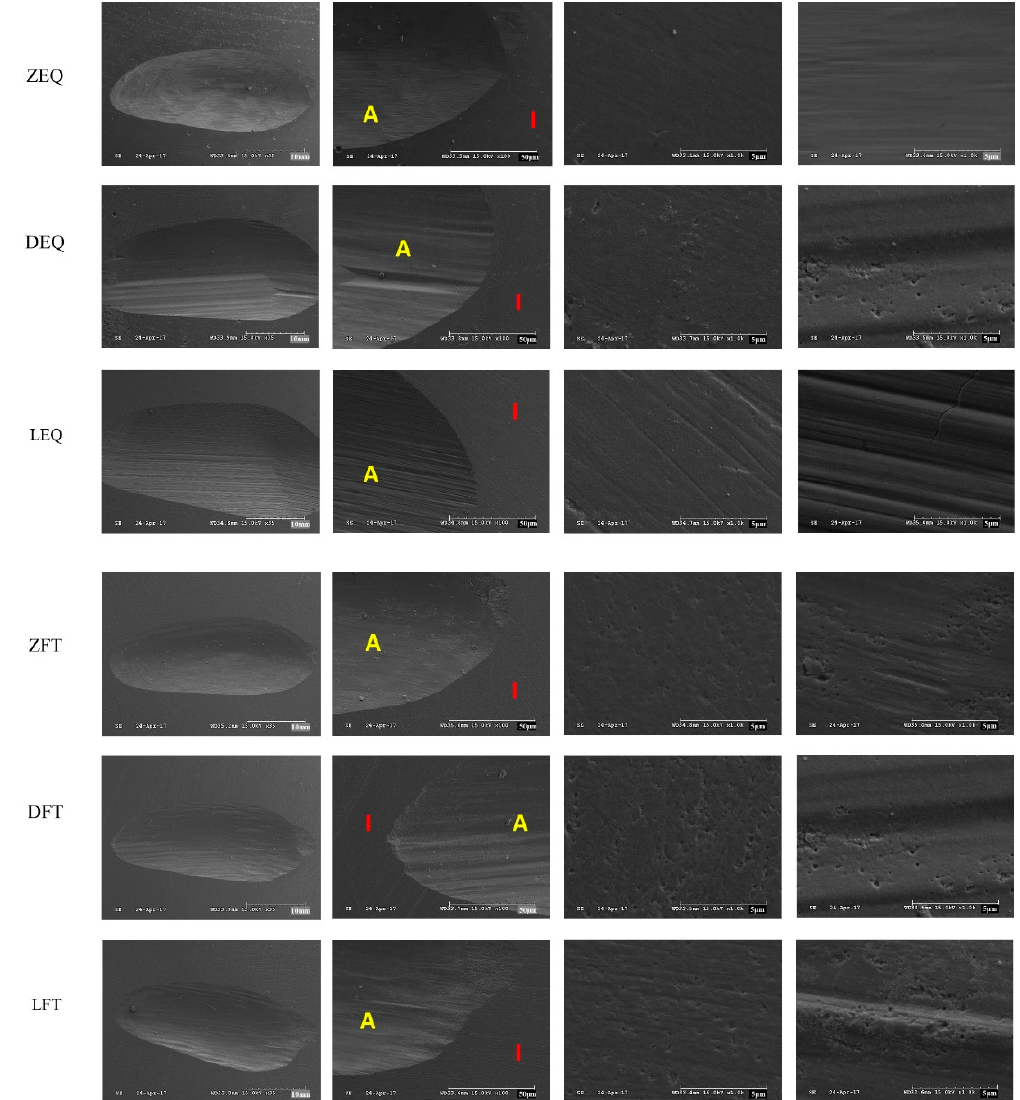
Figure 8. Representative SEM images of composite resin surfaces: ZMG, zirconia opposing MI Gracefil; DMG, lithium disilicate opposing MI Gracefil; LMG, leucite opposing MI Gracefil; ZGD, zirconia opposing Gradia Direct P; DGD, lithium disilicate opposing Gradia Direct P; LGD, leucite opposing Gradia Direct P; ZEQ, zirconia opposing Estelite Σ Quick; DEQ, lithium disilicate opposing Estelite Σ Quick; LEQ, leucite opposing Estelite Σ Quick; ZFT, zirconia opposing Filtek Supreme Ultra; DFT, lithium disilicate opposing Filtek Supreme Ultra; LFT, leucite opposing Filtek Supreme Ultra. I, Intact area; A, Abraded area.